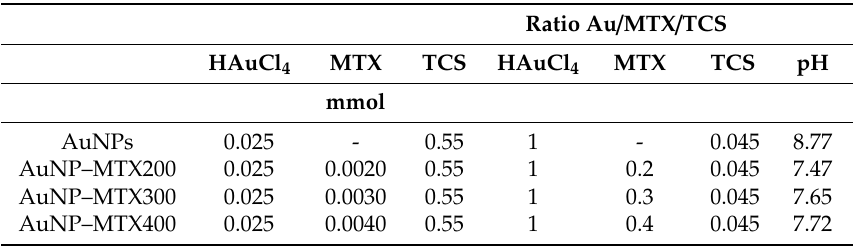
Table 3. Experimental conditions used to synthesize AuNPs and AuNP–MTX